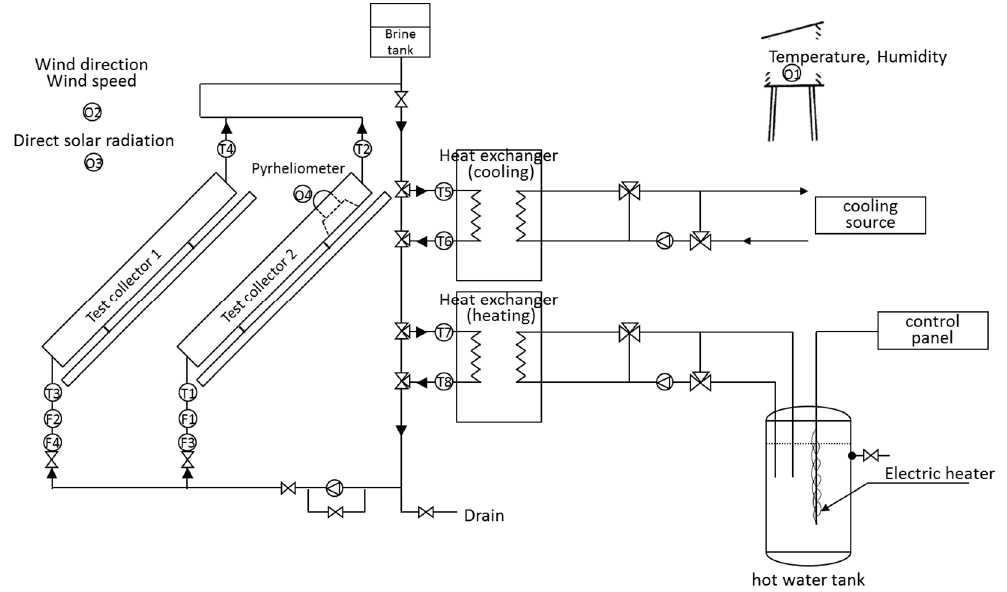
Figure 1. Schematic of experimental arrangement.